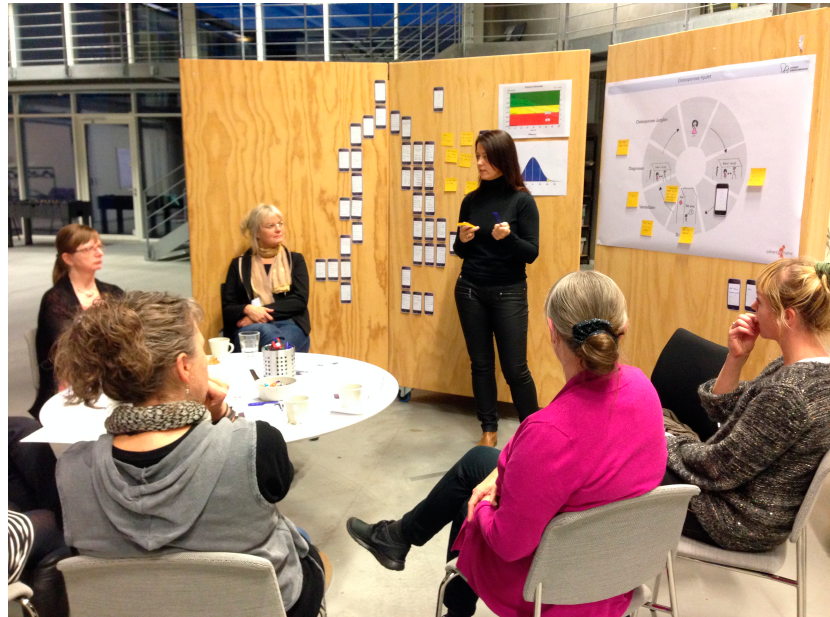
Figure 5. This picture is from the third workshop. Women and researchers from the team